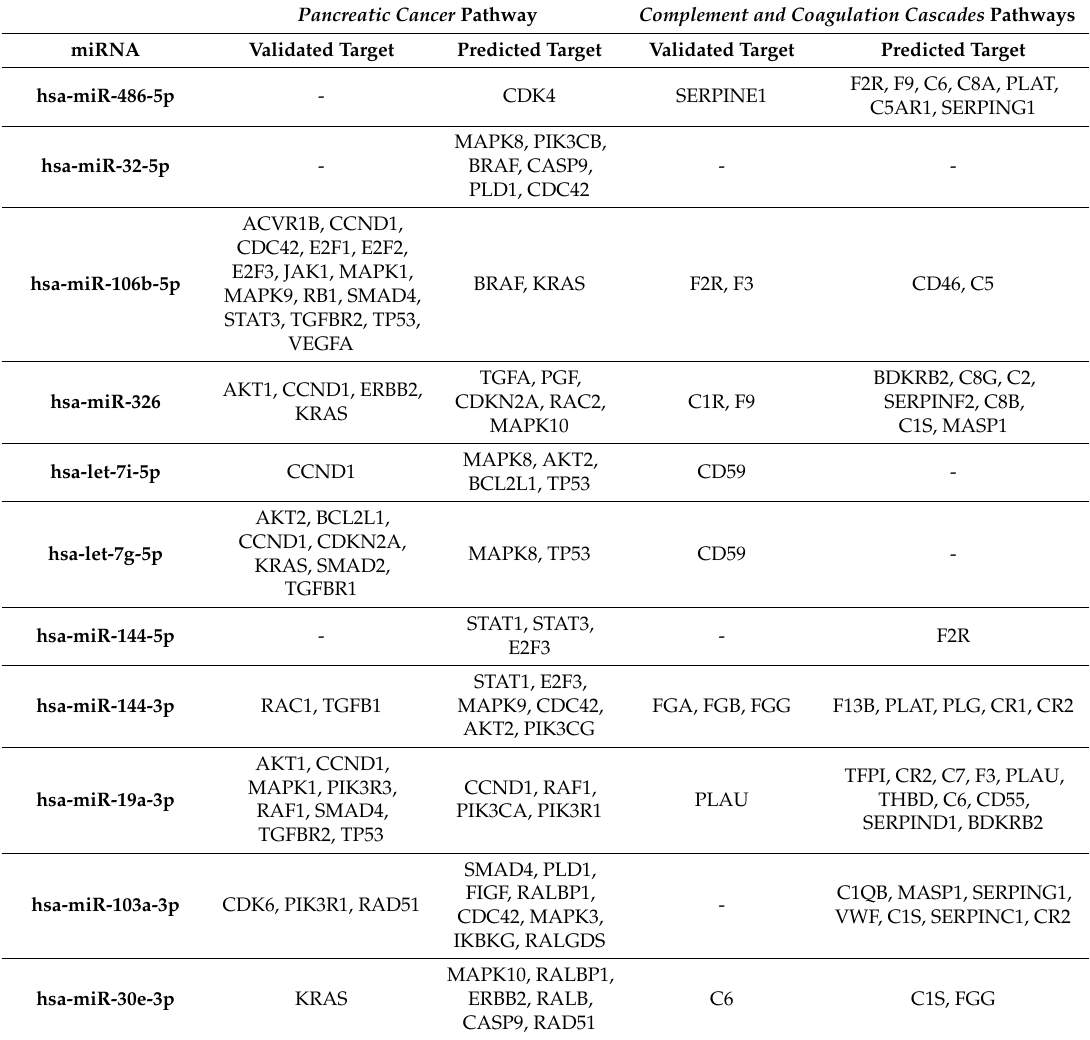
Table 4. Validated and predicted targets of the 11 miRNAs included in the predictive model of VTE in PDAC and DECC patients at inclusion. These target proteins were identified using miRWalk 2.0 and were further integrated within the pancreatic cancer pathway and the complement and coagulation cascades pathway from KEGG. Validated targets are those that have been empirically validated to be regulated by a miRNA. Predicted targets are those that have been theoretically estimated based on the free binding energy between a miRNA and a putative target mRNA